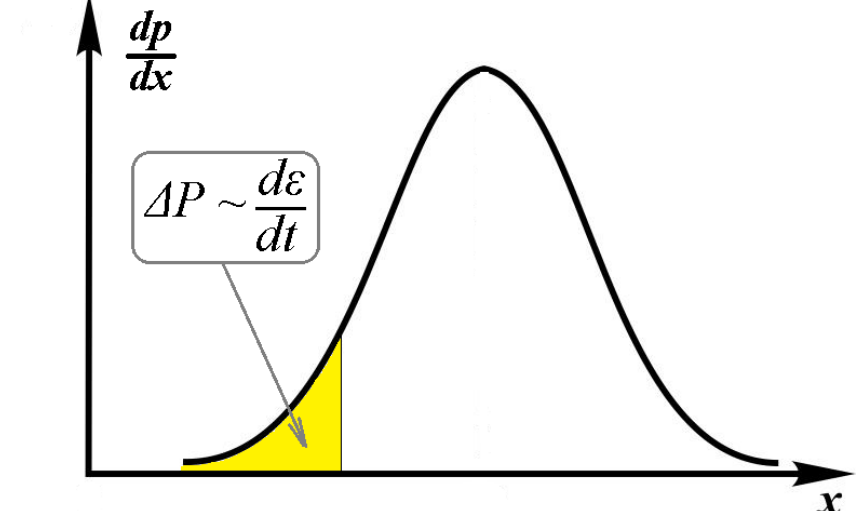
Fig. 1. The part of the distribution that determines the size of the fragments is bounded and depends on the strain